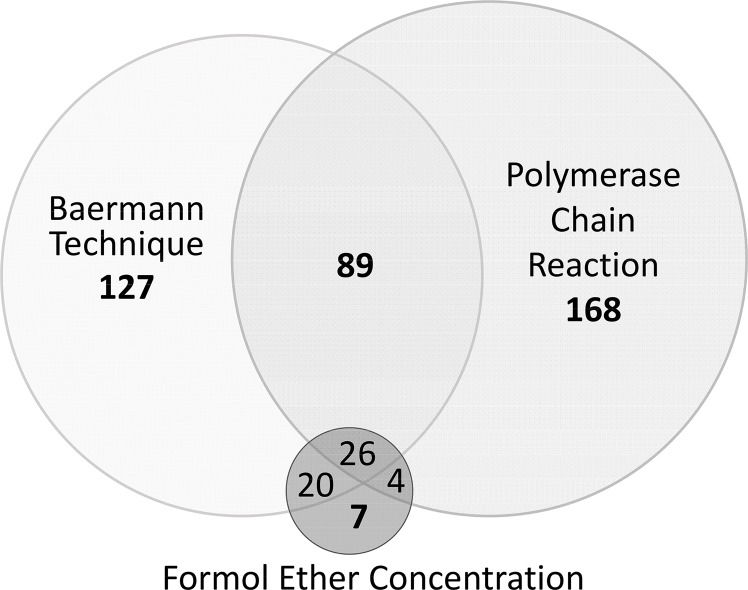
Venn diagram comparing Strongyloides stercoralis diagnosis of the 441 positive results by the Baermann, Formol Ether Concentration and Polymerase Chain Reaction techniques.